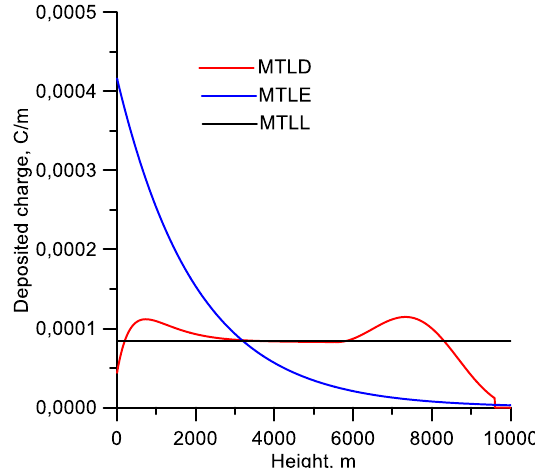
Figure 13. Charge deposited by the return stroke along the leader channel by the MTLD, MTLE and MTLL models. In the MTLE model, λ = 2 km and, in the MTLL model, H = 10 km. These expressions for the attenuation functions, together with the current dispersion defined by Equations (17) and (18) with t 0 = 2.5 µ s and λ r = 500 m, represent the model parameters necessary to define the attenuation and dispersion of the return stroke current and the resulting electromagnetic fields from first and subsequent strokes in different geographical regions. Typical fields are obtained when the speed of the subsequent return stroke is kept around 1.5 × 10 8 m/s and when the corresponding speed of first return strokes is defined by v = v 0 e − z / λ v with v 0 = 10 8 m/s and λ v = 10 km. Unfortunately, the